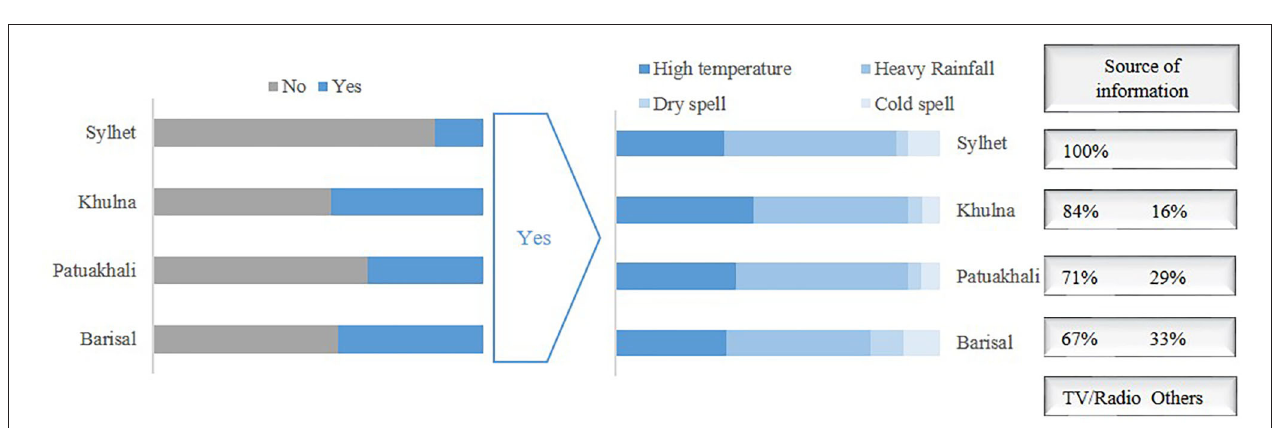
FIGURE 7 | Current extent of weather forecasts used by fish producers in study